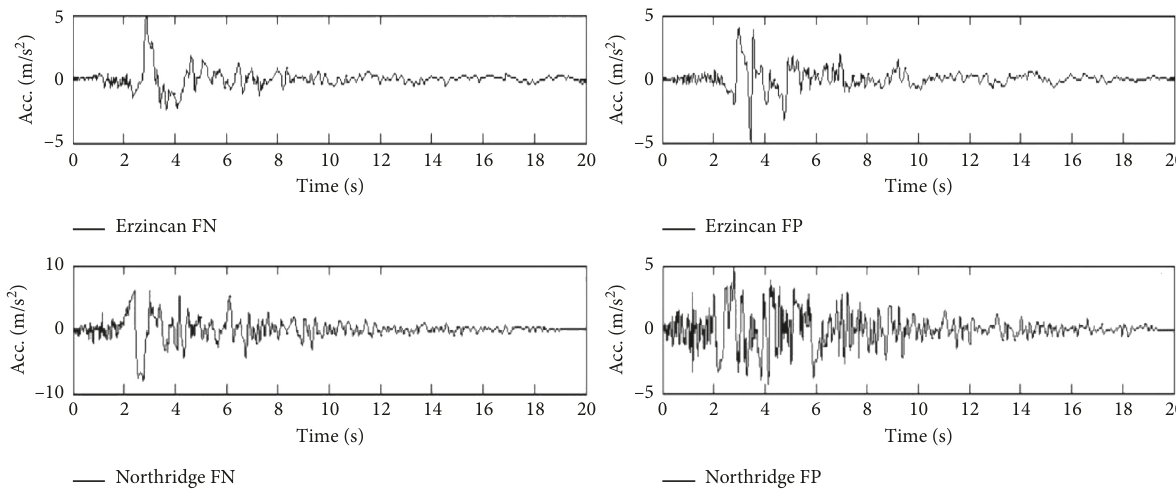
Figure 6: Fault normal and fault parallel components of the earthquake records.